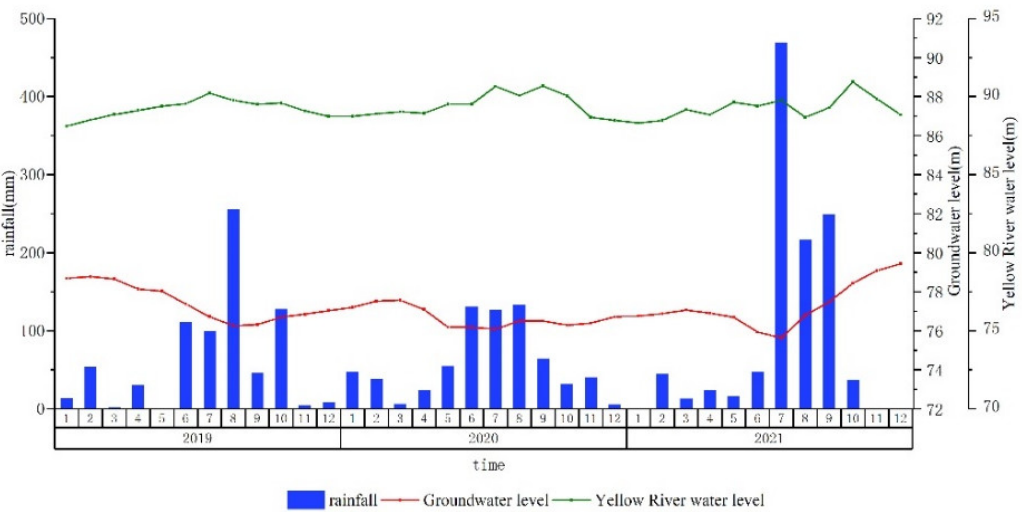
Figure 6. Water level curve of shallow groundwater monitoring points in the study area.